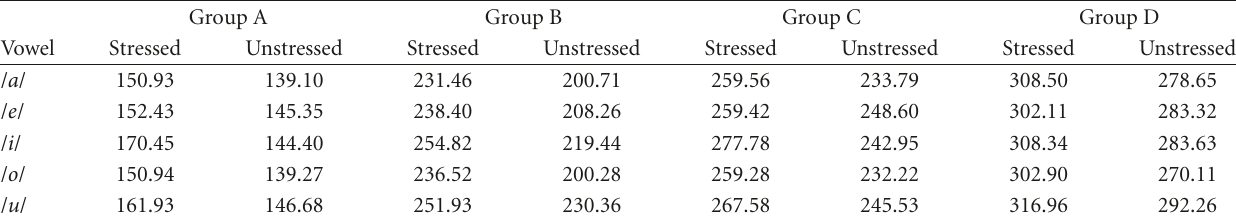
Table 9: Mean ( μ ) values of pitch in the impaired corpus for correct